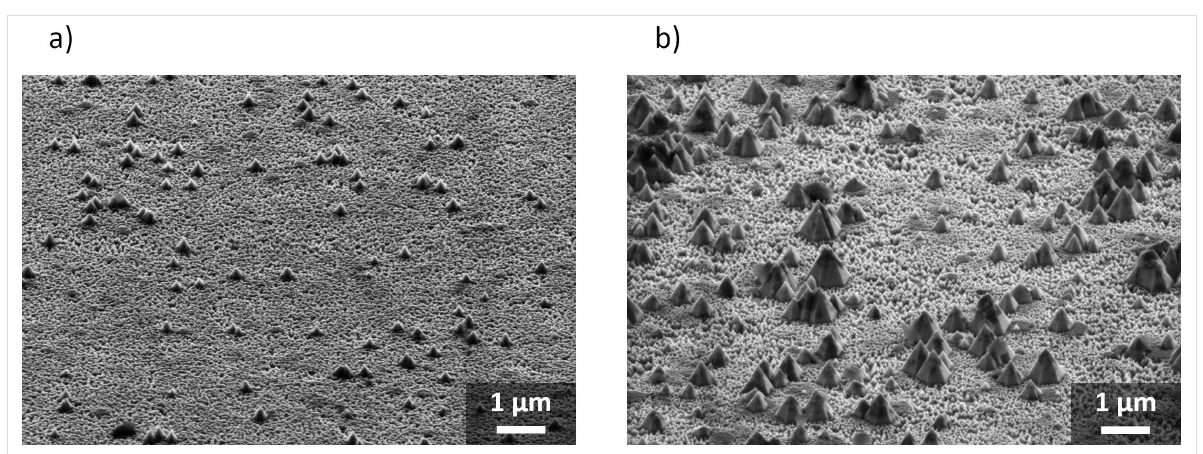
saturated at 240 ± 17 nm to form a plateau region.